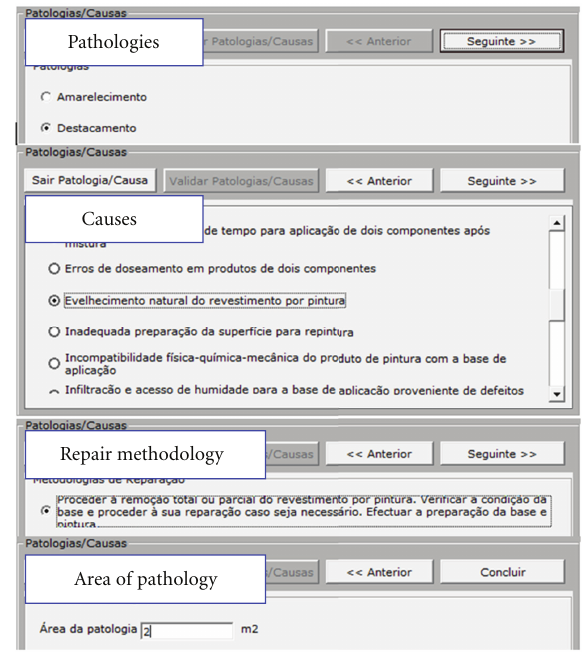
Figure 5: Interface for the selection of the irregularity, probable cause, area, and repair